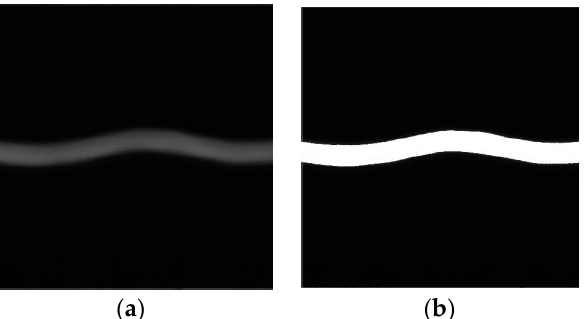
Figure 8. Yarn image processing effect. ( a ) Original image. ( b ) Threshold image segmentation.